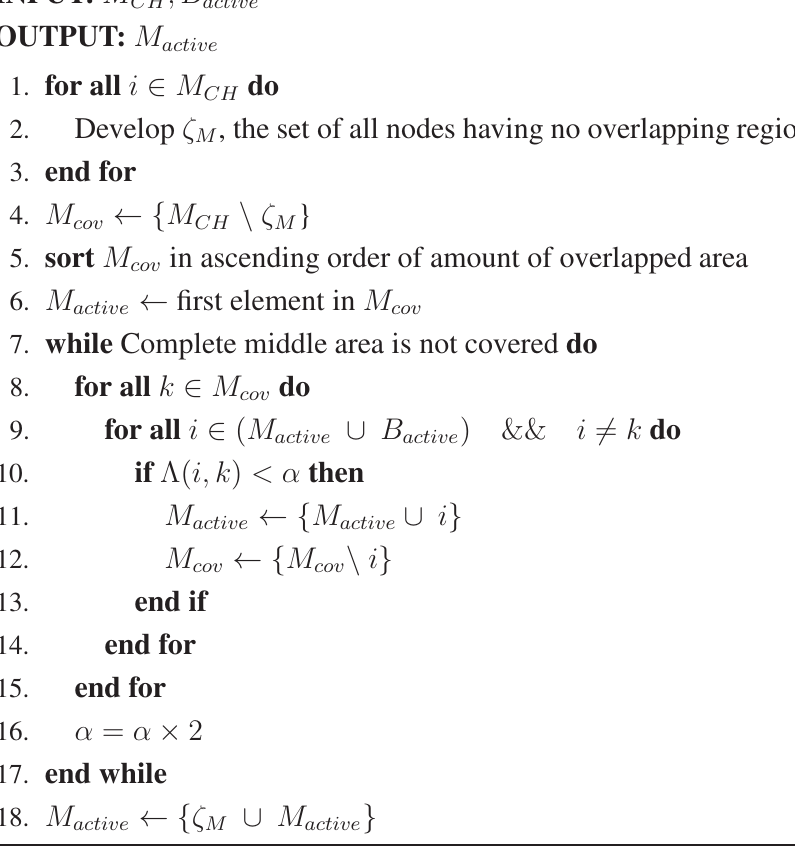
Algorithm 3 Middle area coverage algorithm, at each